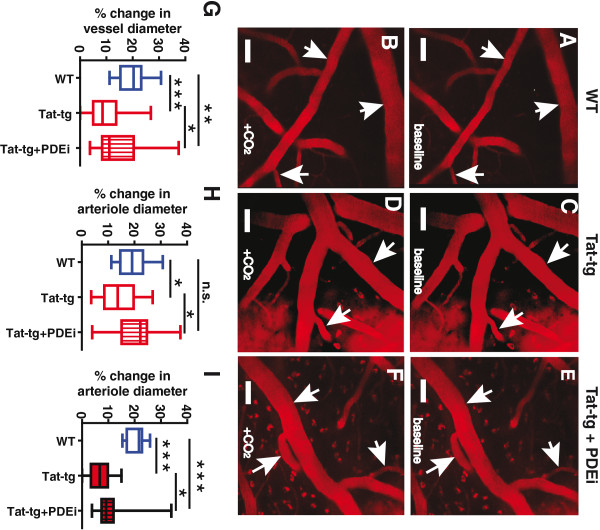
Dilatory capacity of pial arterioles of Tat-transgenic mice is decreased. (A-F) Representative images of dilatory response of pial arterioles in wild type (WT), Tat-transgenic (Tat-tg), and Tat-tg mice treated with PDE5 inhibitor gisadenafil (PDEi), taken before (A, C, E) and after (B, D, F) exposure to 30 seconds of 6% CO2. 25X magnification. Arrows point to representative arterioles. Scale bar is 50 micrometers (μm). (G) Average magnitude of vessel dilation after exposure to CO2 (all vessels; initial diameters 1 to 50 μm). Data shown were collected from seven WT mice (a total of 23 arterioles were analyzed), seven Tat-tg mice (a total of 36 arterioles), and seven Tat-tg mice treated with PDEi (a total of 45 arterioles). (H) Average magnitude of vessel dilation after exposure to CO2 (small vessels only; initial diameters 1 to 25 μm). These data are a subset of those shown in (G). (I). Average magnitude of vessel dilation after exposure to CO2 (larger vessels only; initial diameters 26 to 50 μm). These data are a subset of the data shown in (G). G-I. Data are plotted as box- plots. Maximum and minimum outliers are represented by whisker endpoints. Box segmentation represents lowest datum within 1.5 interquartile range of lower quartile, median and highest datum within 1.5 interquartile range of the upper quartile. Statistical significance denoted as *P <0.05; **P <0.01; ***P <0.001; or n.s., no significant difference; t-test